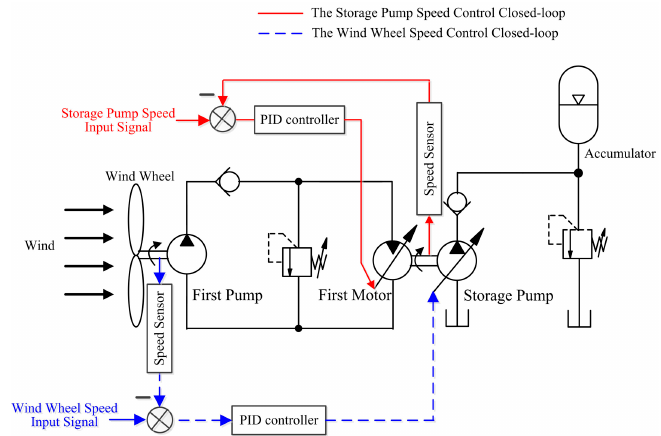
Figure 7. The schematic diagram of the double closed-loop control method.